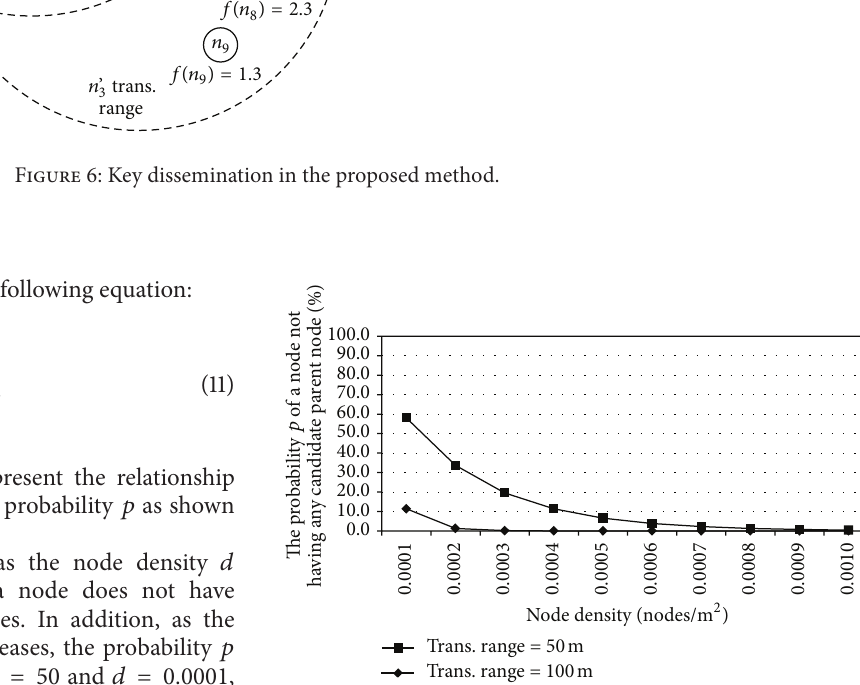
Figure 7: The probability of no candidate parent node versus the node